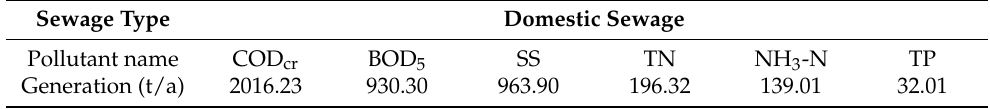
Figure 6. Domestic sewage generation. Figure 7. Classification diagram of sewage generation.